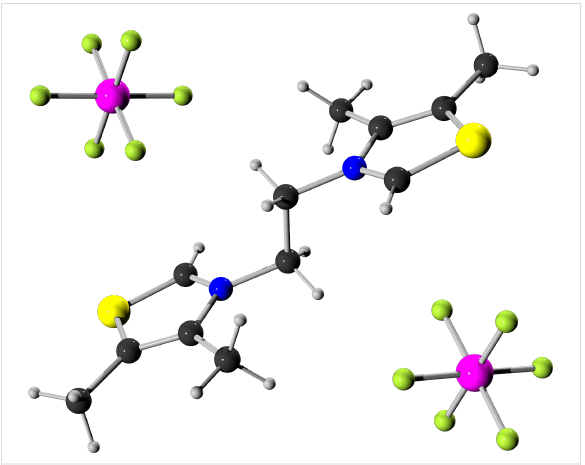
Figure 1: Ball-and-stick model [42,43] of a single crystal X-ray struc- ture of hexafluorophosphate salt 1b (CCDC 1472789). Color code: black carbon, grey hydrogen, yellow sulfur, blue nitrogen, magenta phosphorus, green